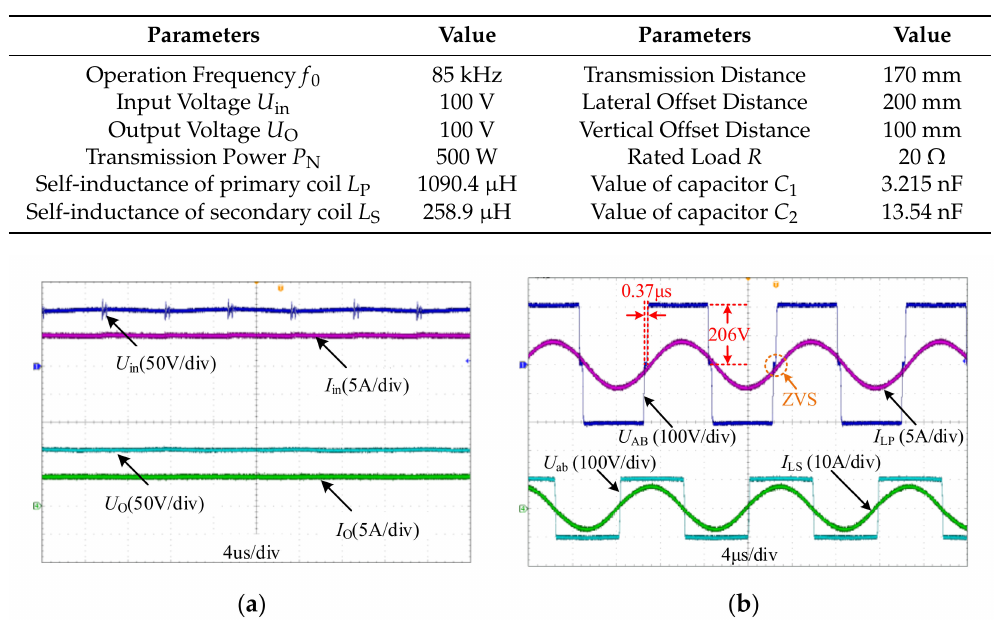
Table 2. Main electrical and physical parameters of the prototype.